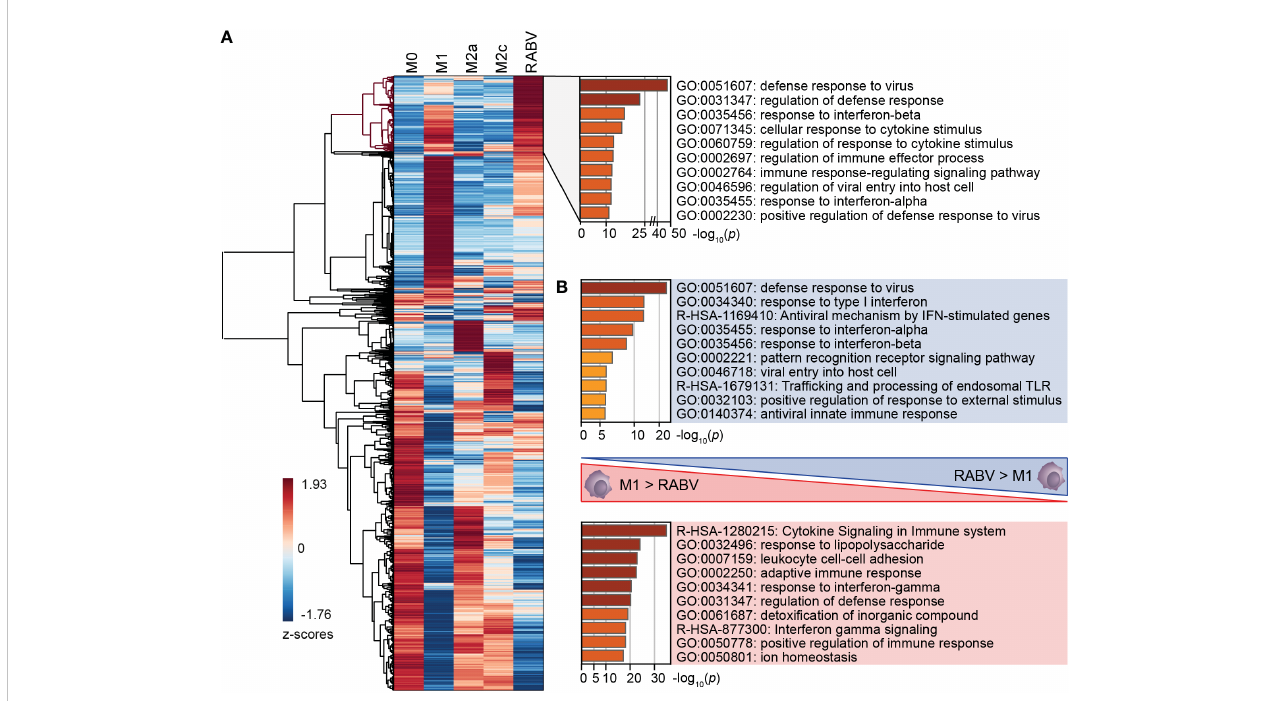
FIGURE 3 Clustering of all DEGs of the fi ve studied macrophage phenotypes, and the major differences in enriched pathways between M1 and RABV macrophages. All genes that were differentially upregulated in at least one phenotype were clustered (A) . A cluster of highly upregulated genes of RABV macrophages (highlighted in red) was submitted to pathway enrichment analysis. Pathway enrichment analyses were also performed on genes that were differently upregulated in RABV macrophages but not in M1 macrophages, and vice versa (B)